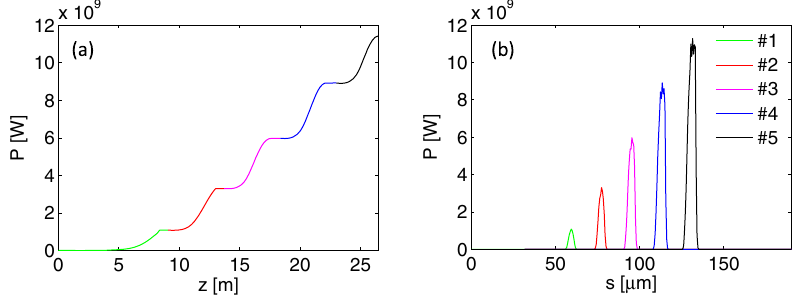
FIG. 8. The FEL gain curve (a) and structure evolutions of the radiation pulse (b) in the C-U modules.